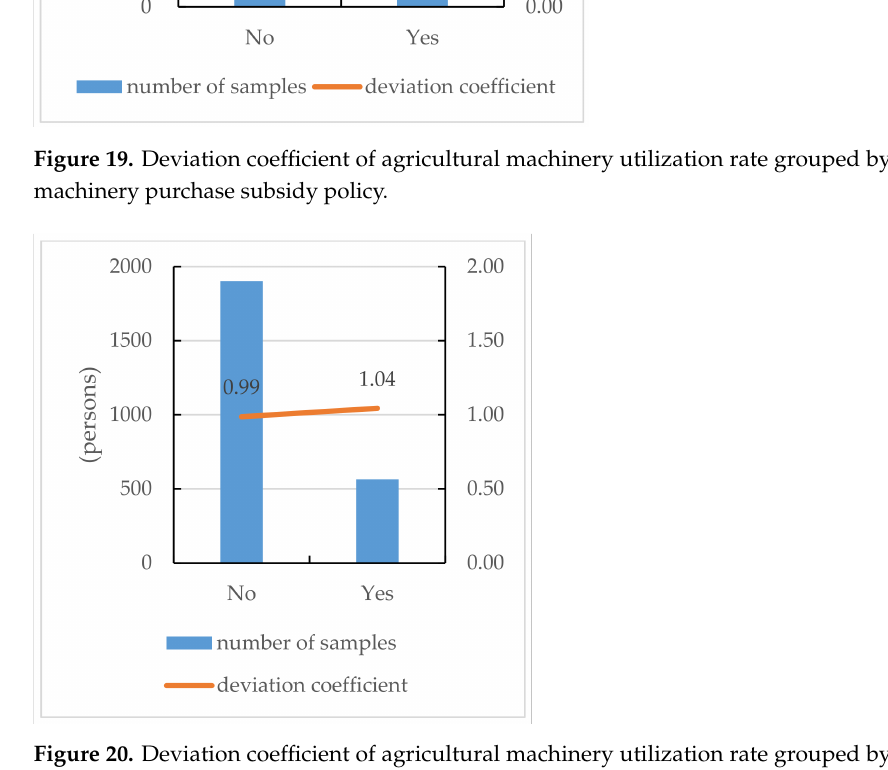
Figure 20. Deviation coefficient of agricultural machinery utilization rate grouped by agricultural machinery insurance.